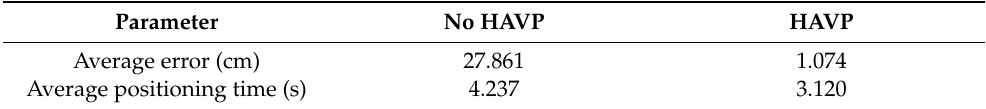
Table 13. Total average error and positioning time of using and not using